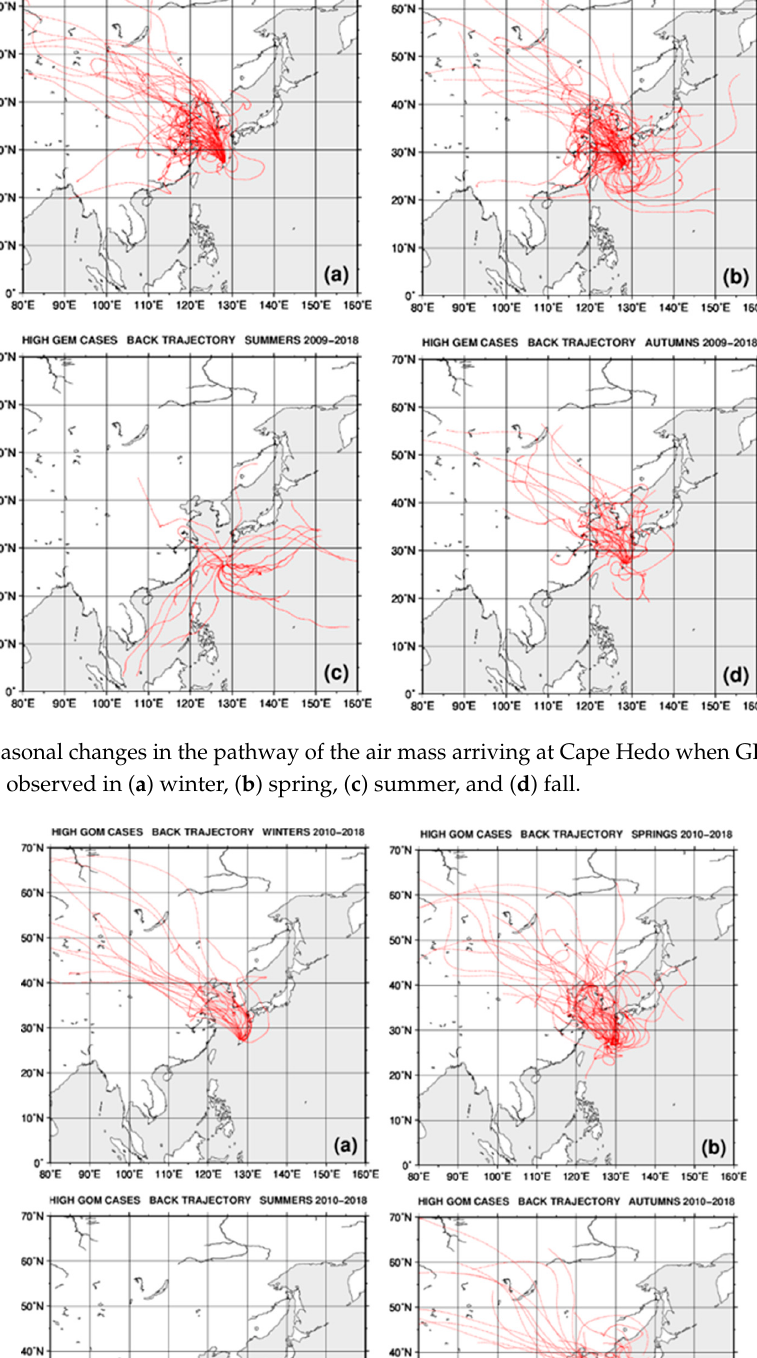
Figure 4. Seasonal variations in the frequency of the pollution events of GEM, GOM, and PBM 2.5 . The pollution events are defined as their values above the mean value plus 3× SD.